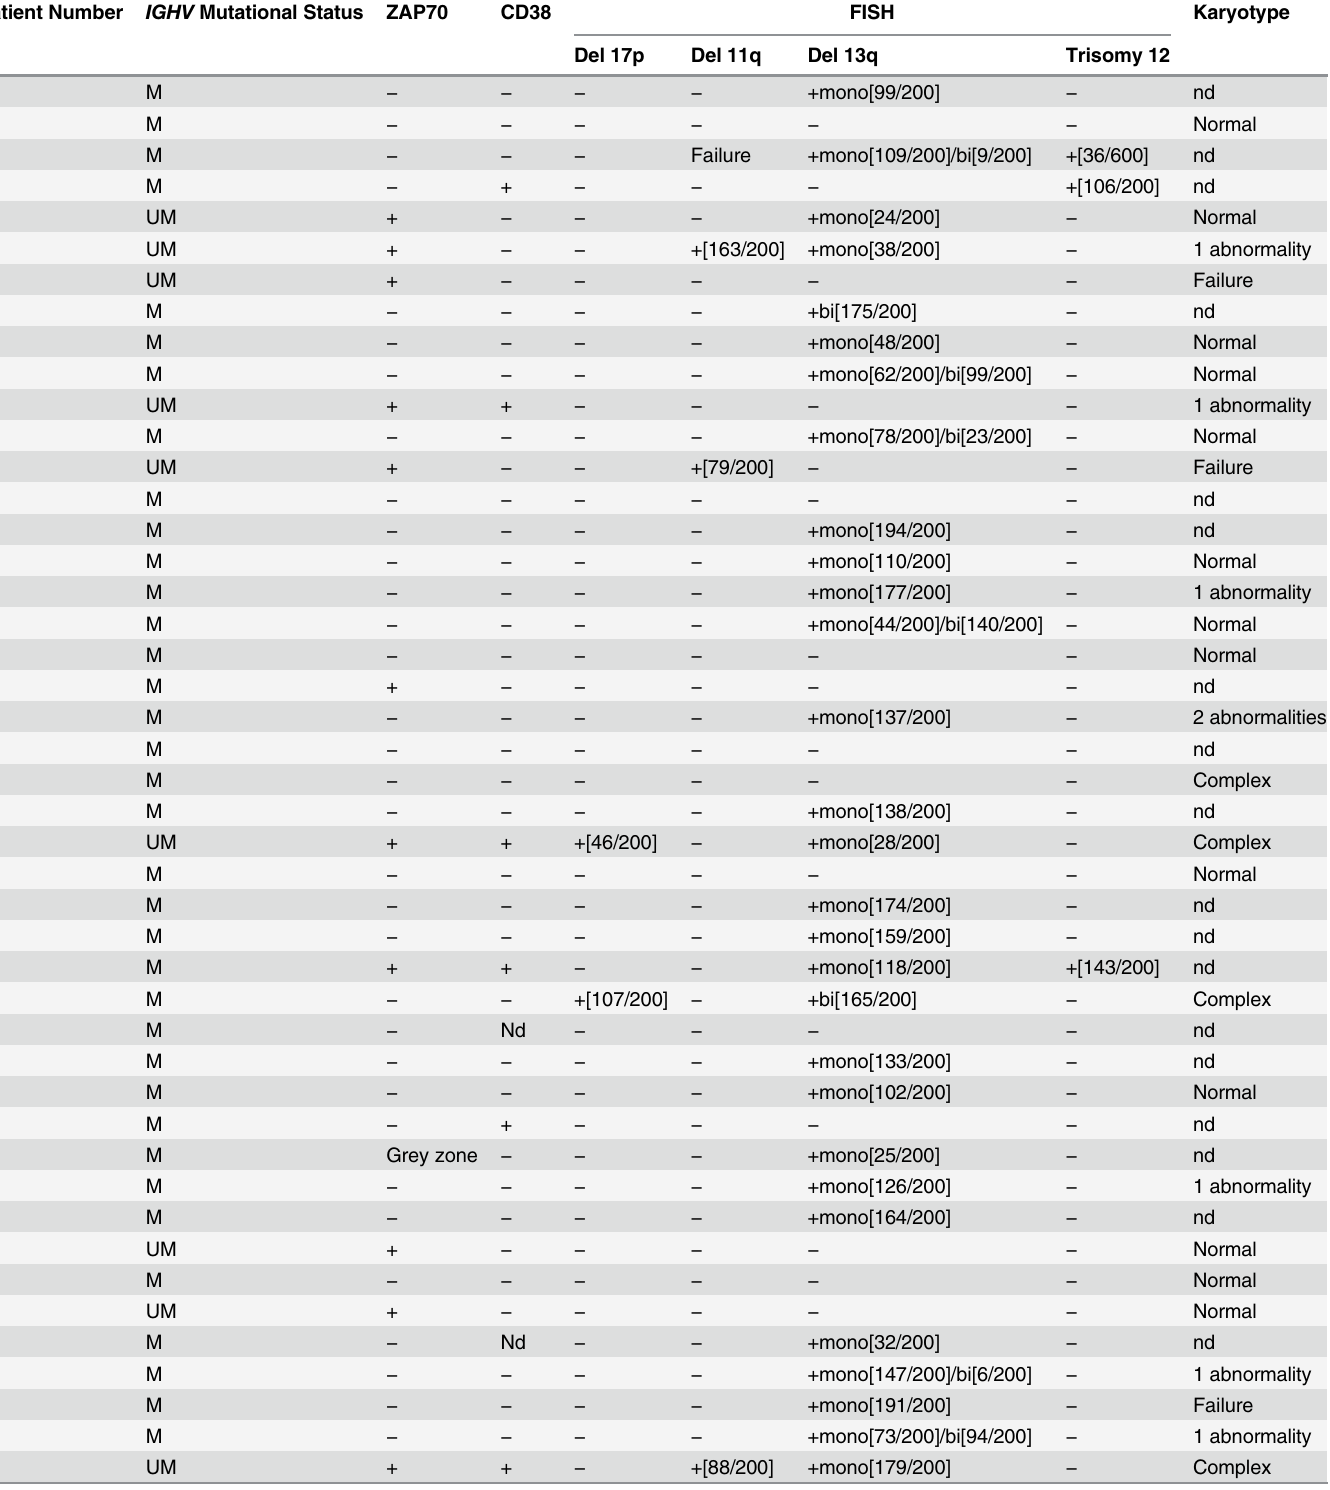
Table 1. Features of CLL patients with clinical Binet Stage